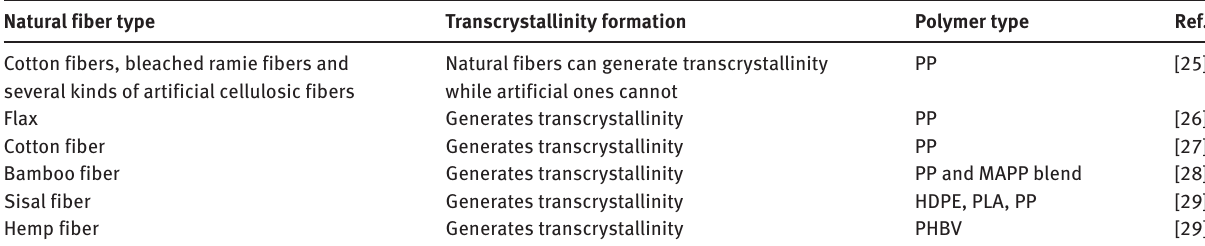
Table 2: The transcrystallinity formation in the natural fibers. Natural fiber type Transcrystallinity